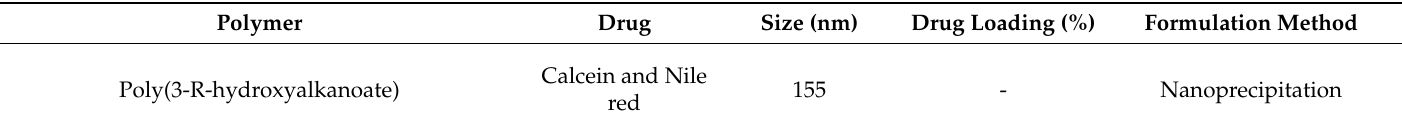
Table 1. Key findings of various polyhydroxyalkanoate (PHA) nanoparticle